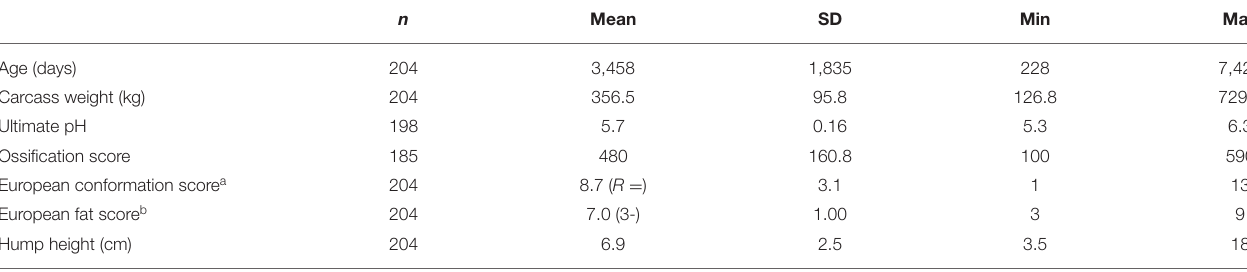
TABLE 1 | Number, mean, SD, minimum, and maximum values for the basic carcass traits.